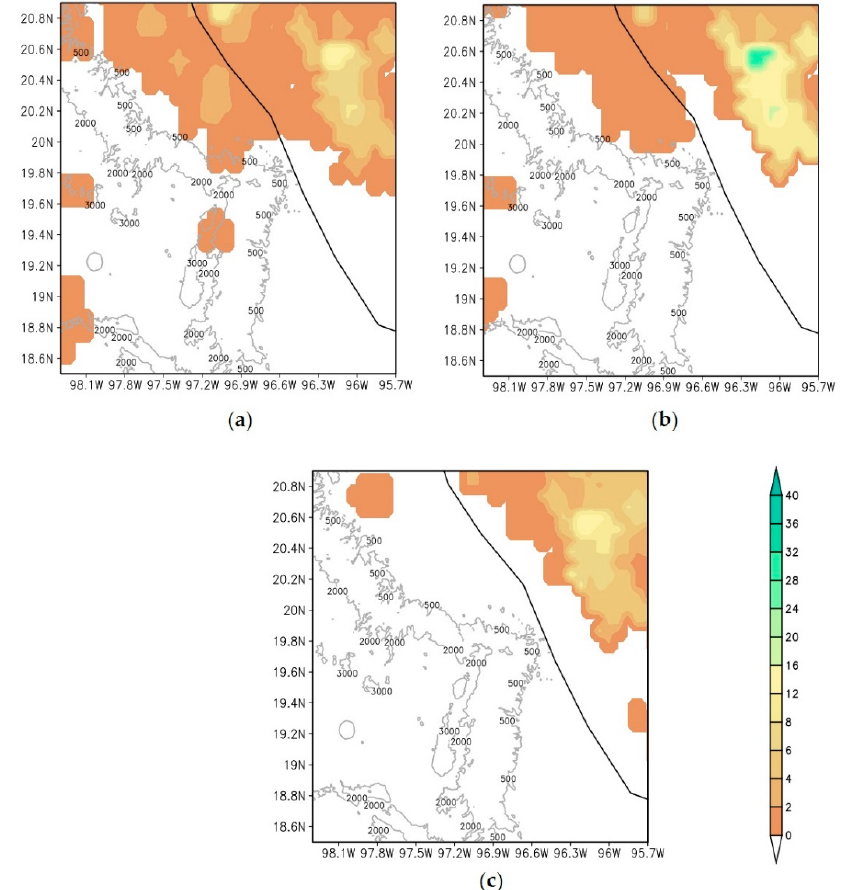
Figure 13. Precipitation (mm h − 1 ) using CMORPH data (8-km spatial resolution) at ( a ) 01 LT, ( b ) 03 LT, and ( c ) 05 LT by July 1, 2015. The contours of 500 and 2000 m.a.s.l. are shown.